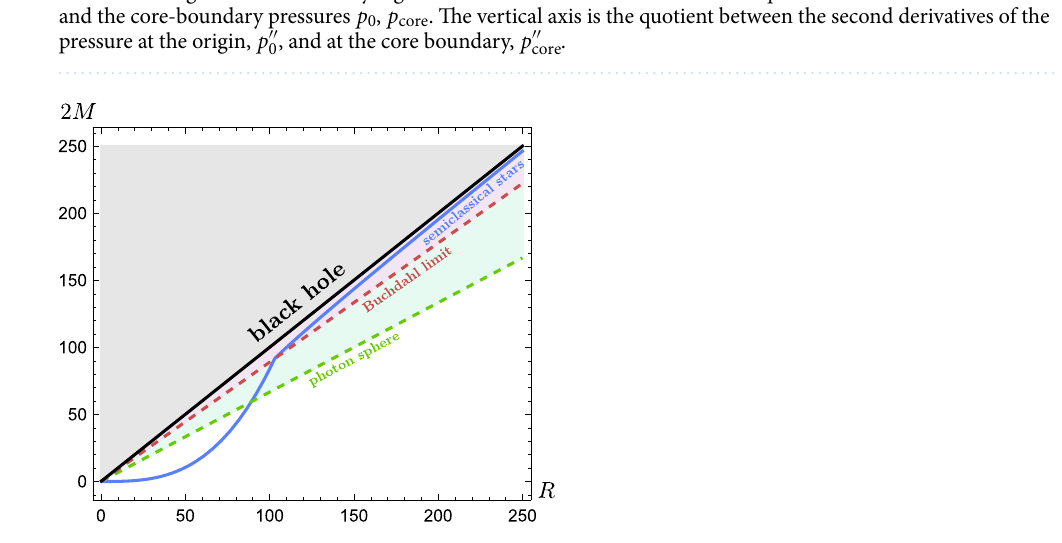
Figure 4. Mass-radius diagram of semiclassical relativistic stars with ρ = 10 − 5 . The black line represents the compactness parameter of black holes ( C R = 1 ) , the dashed red line denotes the Buchdahl compactness bound ( C R = 8 / 9 ) , and the dashed green line is the minimum compactness of objects that exhibit a photon sphere ( C R = 1 / 3 ) . The blue curve represents semiclassical relativistic stars. For stars surpassing the Buchdahl limit, the total mass M grows approximately linearly with the radius R . Each point within the blue curve admits entire families of regulator functions F for which the whole geometry is